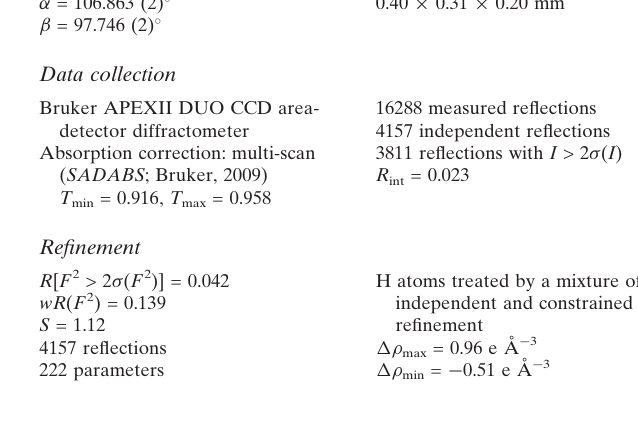
16288 measured reflections 4157 independent reflections 3811 reflections with I > 2 (cid:2) ( I ) R int = 0.023